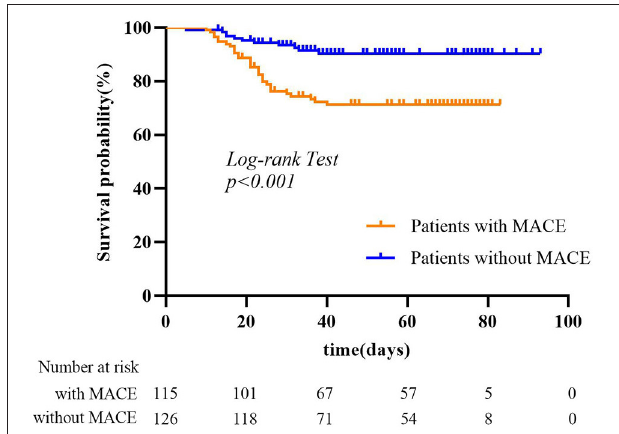
FIGURE 3 | Kaplan–Meier survival curves for patients with MACEs and without MACEs.